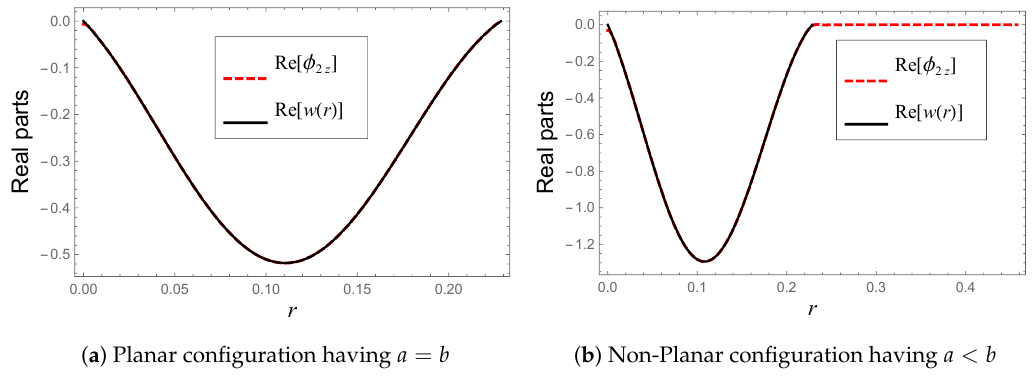
Figure 3. The real part of normal velocity and membrane displacement at z =